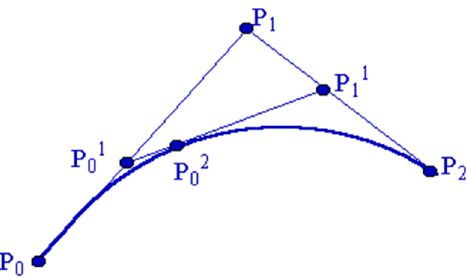
Figure 7. Schematic diagram of Bézier curve fitting.